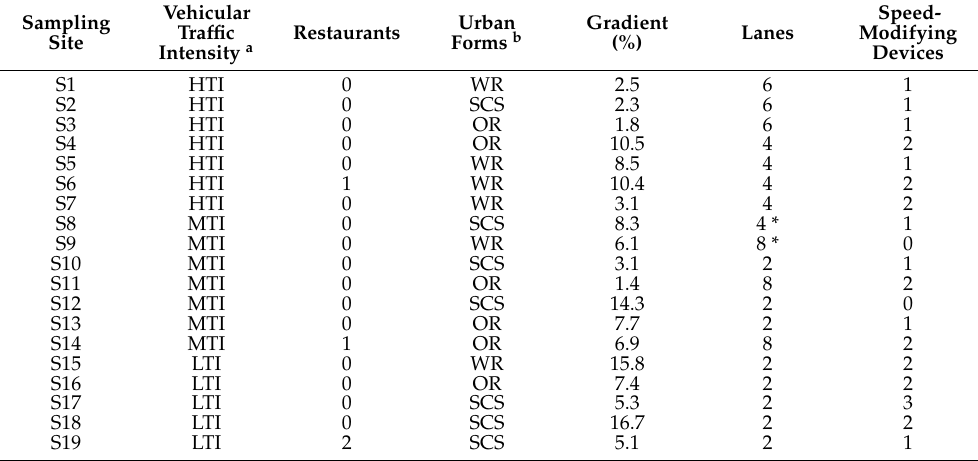
Table 1. Emission sources and road characteristics of the sampling points. Sampling Site